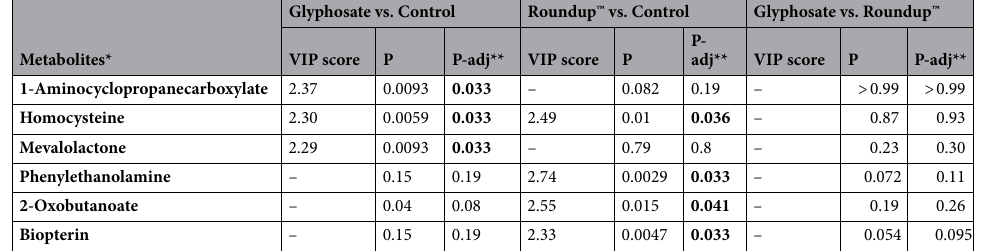
Table 3. The VIP score and fold change of metabolites significantly differentially measured between exposure groups in male pups.